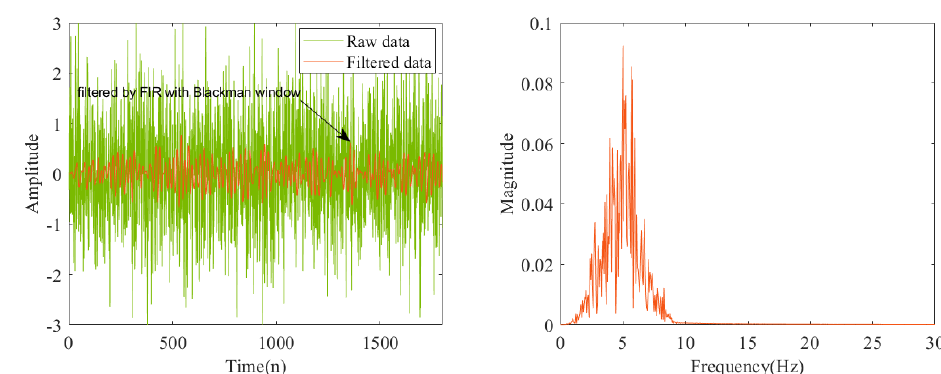
Figure 4. Data of estimation consistency experiment. Raw data is the Gaussian white noise with mean value of 0 and variance of 1. Filtered data is obtained by filtering the raw data with a high-order FIR filter. The figure on the right is the spectogram, distributed around 5 Hz, of filtered data.